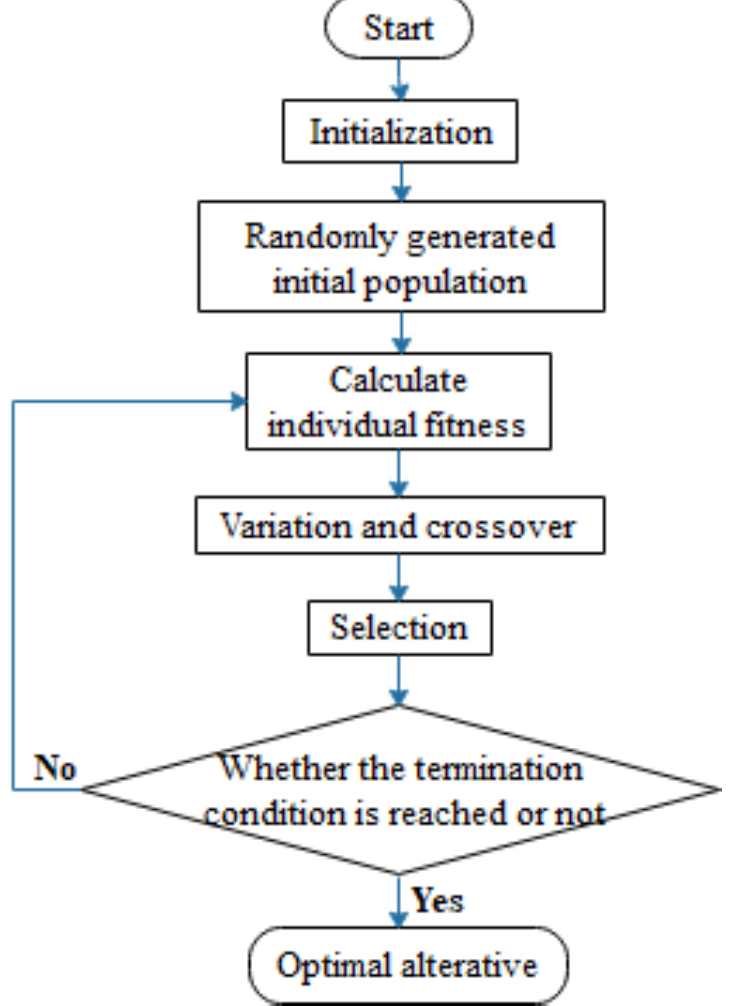
Figure 7. Differential evolution algorithm program block diagram.